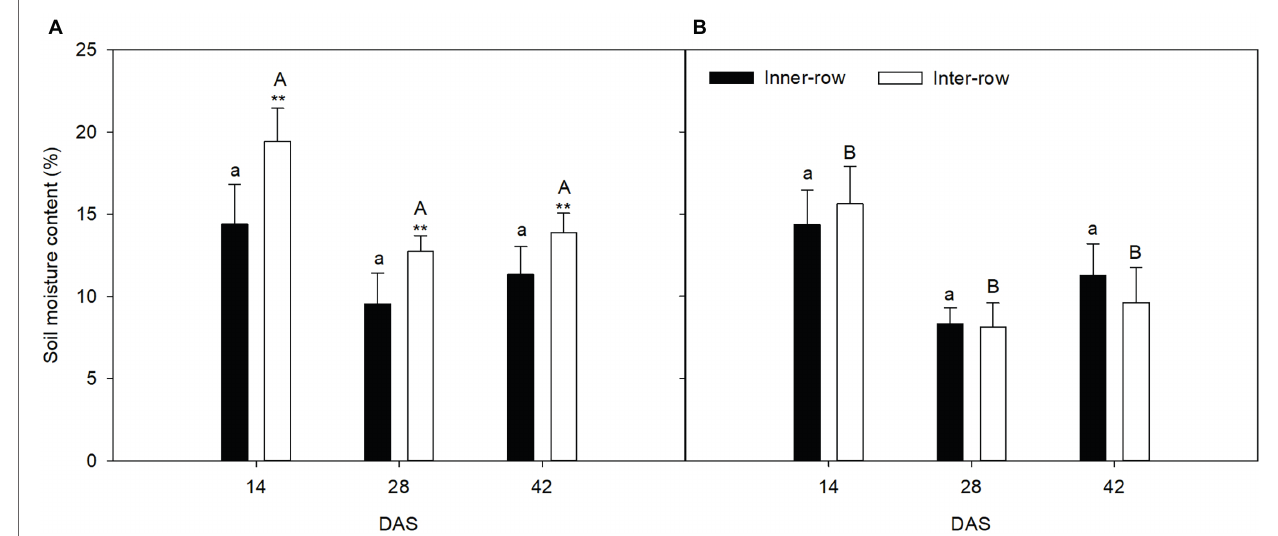
FIGURE 4 | Effects of FU (A) and FL (B) on soil moisture content of ridge/inter-row and furrow/inner-row at 14, 28, and 42 days after sowing (DAS). Solid bars show furrow/inner-row soil moisture content; hollow bars show ridge/inter-row soil moisture content. Values are means ( n = 4) ± SE. Asterisks above symbols indicate significant differences in soil moisture content between inter-row and inner-row at p ≤ 0.05. Same capital letters indicate no significant difference in inter-row soil moisture content between two seeding patterns at p ≤ 0.05. Same lowercase capital letters indicate no significant difference in inner-row soil moisture content between two seeding patterns at p ≤ 0.05.